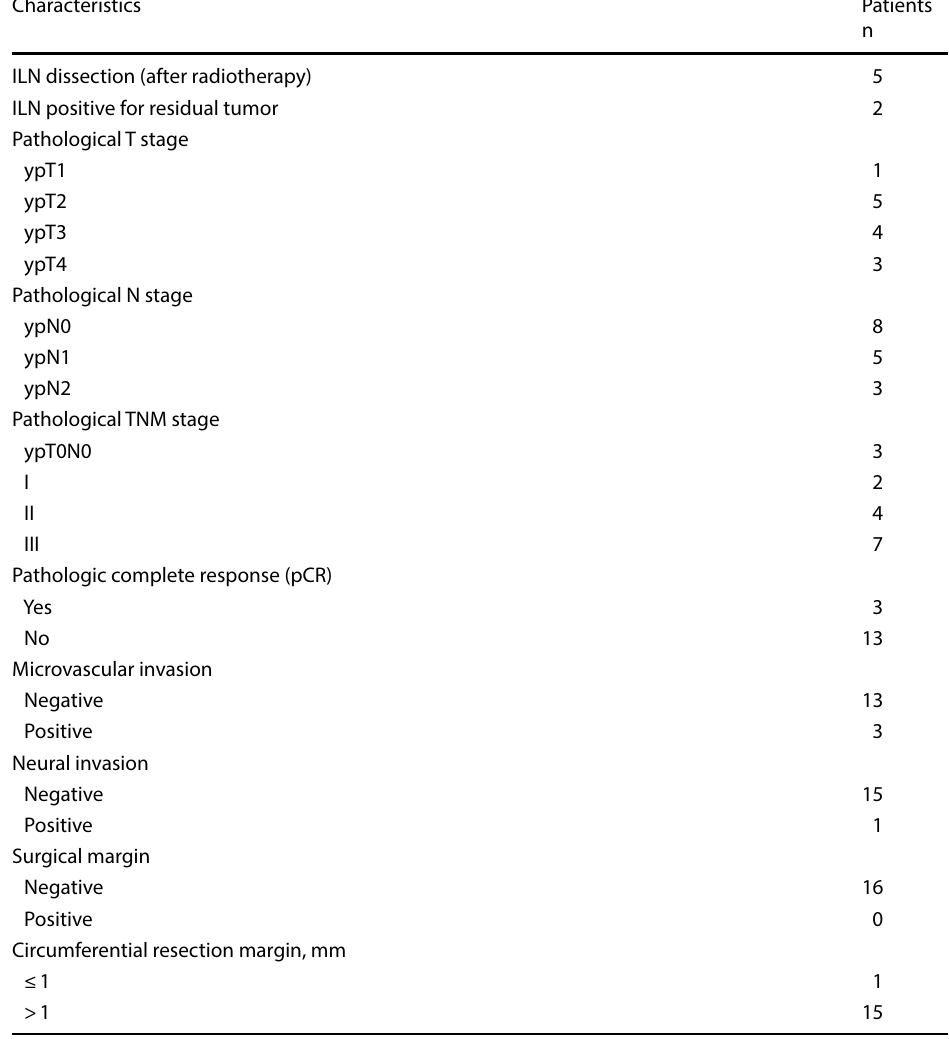
Table 3 Postoperative clinicopathological characteristics in 16 patients with LARC and synchronous